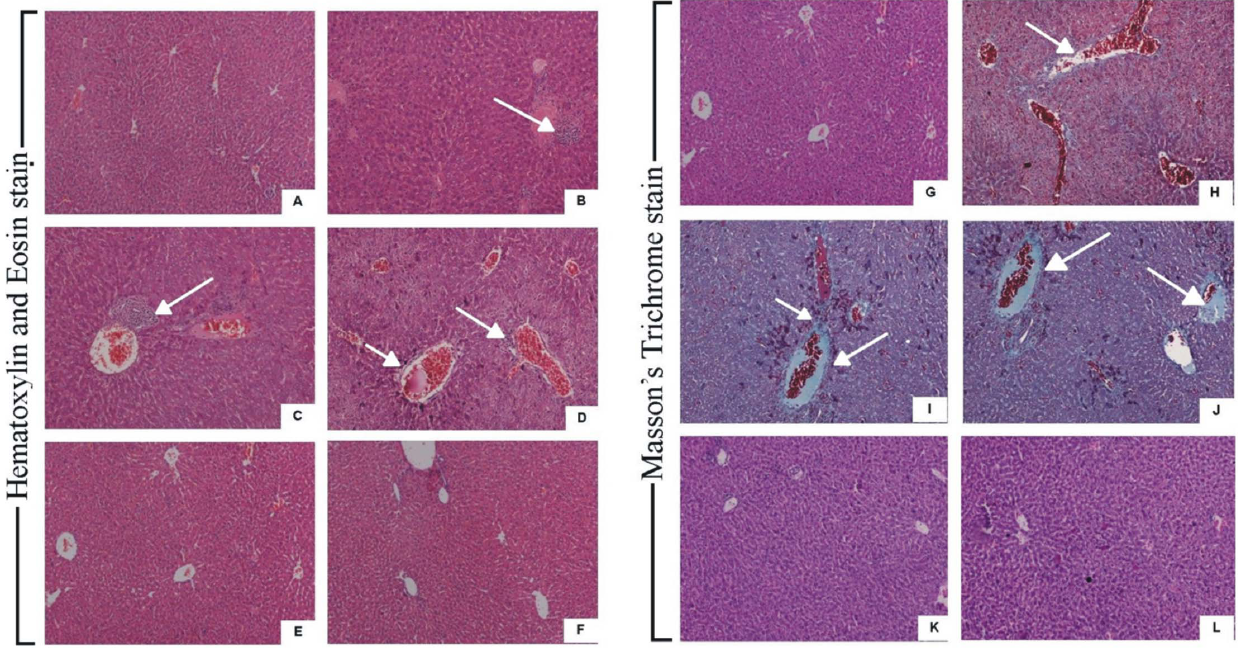
Figure 2. Liver tissue in antibiotic alone group showed high liver inflammatory response with infiltration of neutrophilic granulocytes (white arrow) indistinct boundaries between cytoplasm and nucleus of liver cells, hepatic portal haemorrhage and hepatocyte necrosis (white arrow) [Fig.2 (amikacin) C, I (cefotaxime) D, J] as compared to infection control (Fig.2 B, H). Uninfected group (control) did not show any sigh of inflammatory response (Fig.2 A, G). Amikacin-zingerone treatment (Fig.2 E, K) as well as cefotaxime- zingerone treatment (Fig.2 F, L) significantly protected mice from hepatic inflammation induced by antibiotic mediated endotoxemia and liver tissue appeared to be normal as was observed in control group (uninfected group).